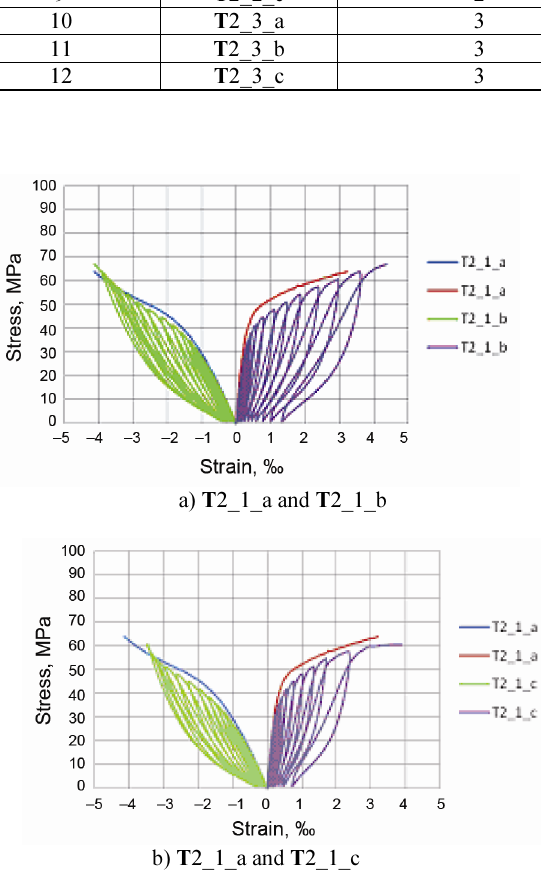
Fig. 15. Cyclic and monotonic stress-strain curves for T 2_1_a/b and T 2_1_a/c specimens